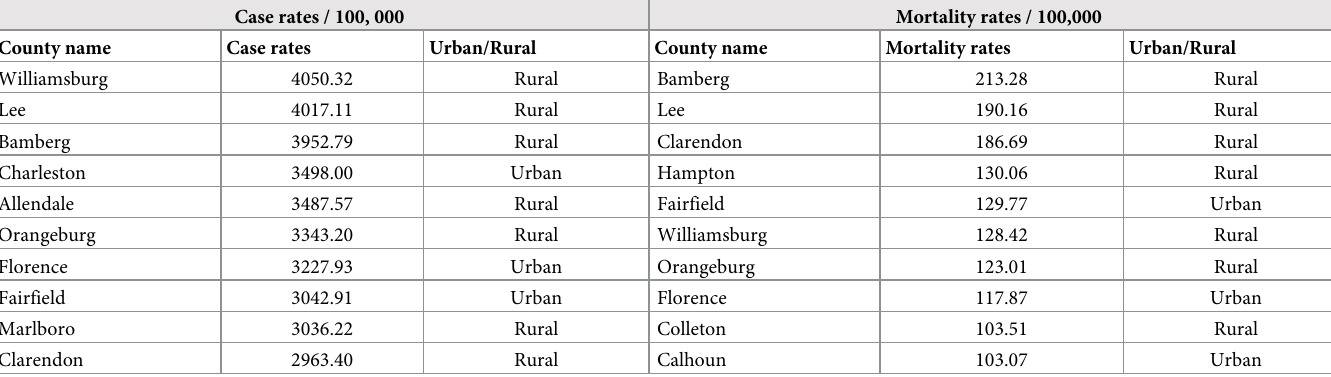
Table 2. Counties with the highest ranking of confirmed case rates and mortality rates, March 1-September 5, 2020. Case rates / 100,